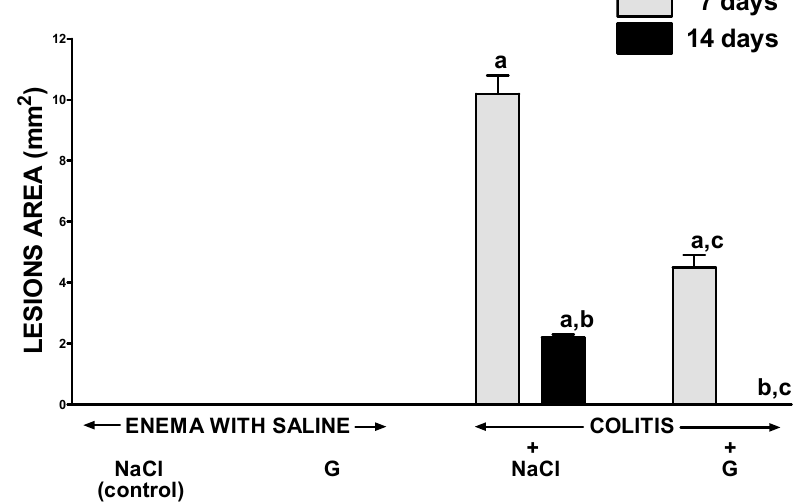
Figure 1. Effect of intraperitoneal administration of saline (NaCl) or ghrelin (G) on the area of colonic mucosa lesions after seven or 14 days from enema with saline or colitis induction. Mean value ± SEM. n = 10 animals in each group. a p < 0.05 compared to control at the same time of observation; b p < 0.05 compared to a value observed at the same group after seven days from colitis induction; c p < 0.05 compared to rats with colitis treated with NaCl at the same time of observation.